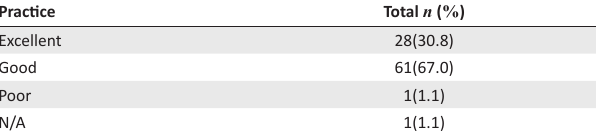
TABLE 2: Self-reported attitudes towards health promotion.